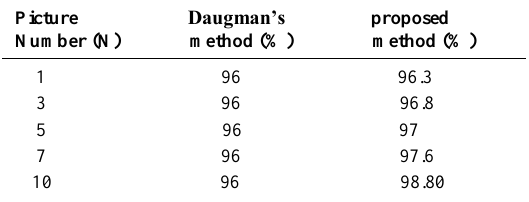
Table 7. Comparing identity distinction precise of proposed method with Daugman's method based on register teaching picture number (N=1, 3, 5, 7,